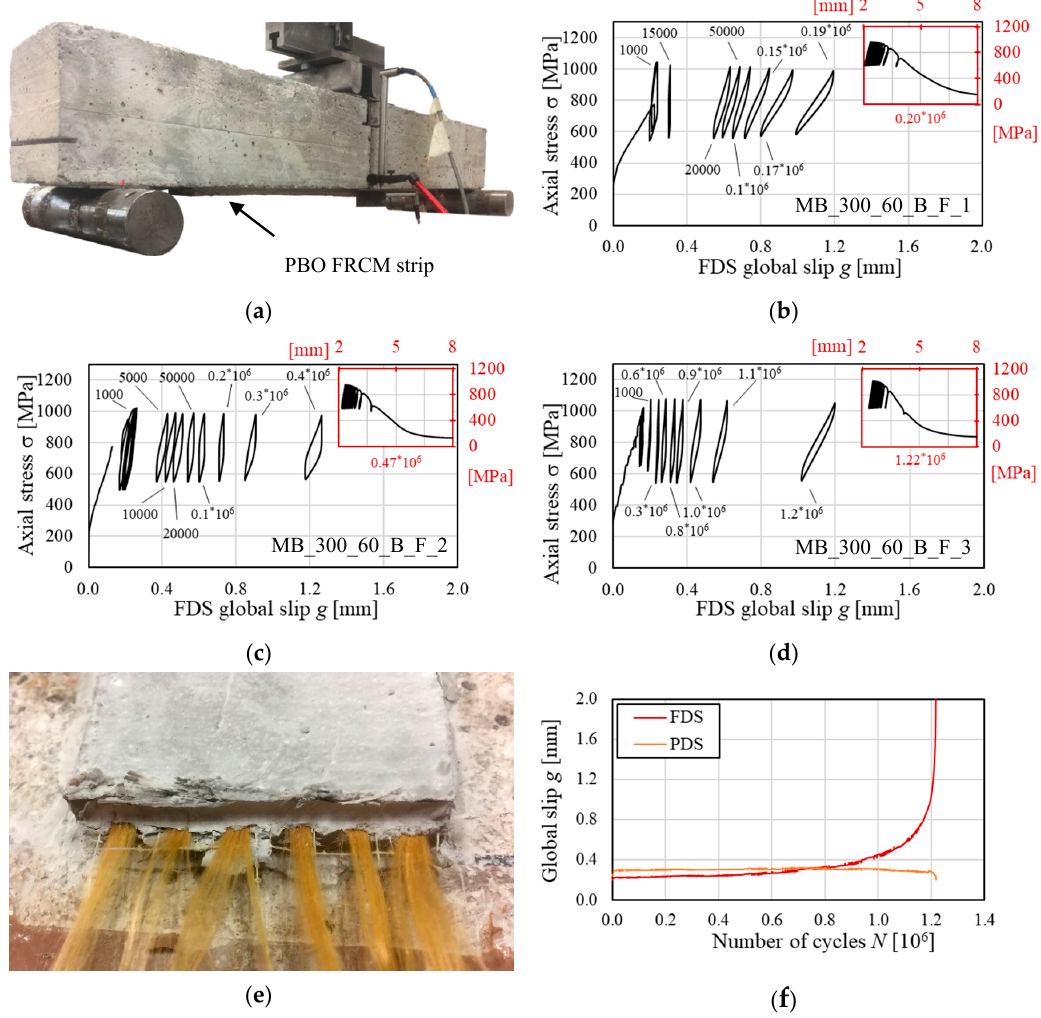
Figure 5. ( a ) Photo of specimen MB_300_60_B_F_3 before the beginning of the test. Load responses of